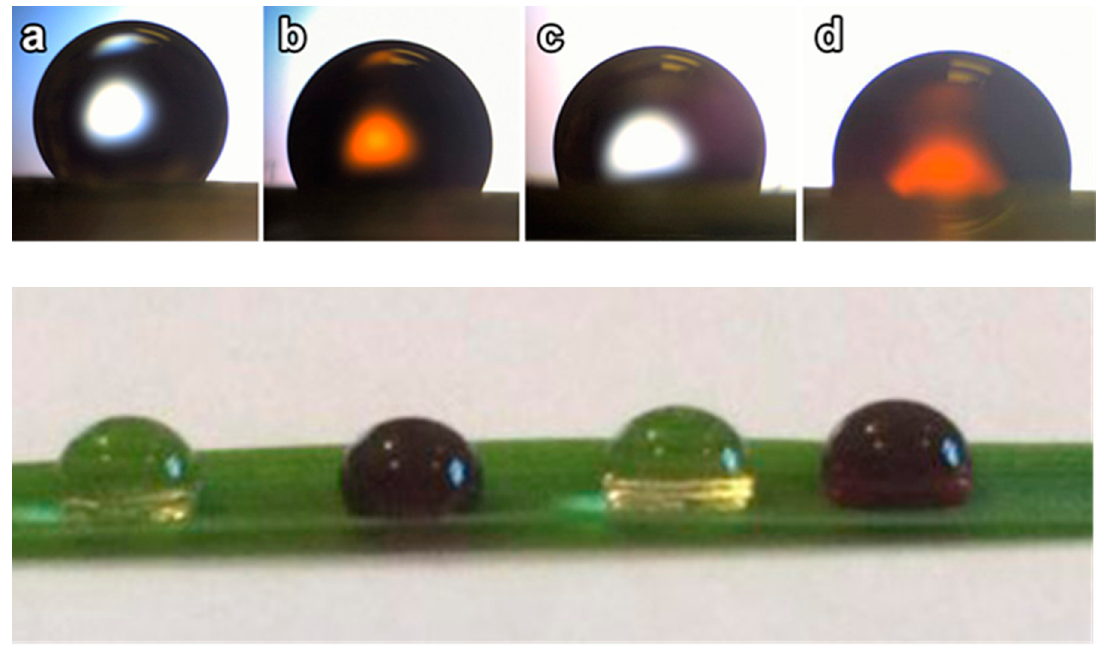
Figure 5. Images of the foliar spray droplets deposited on the surface of wheat leaf: ( a ) triple-distilled water; ( b ) HS (solution of potassium humate); ( c ) Fe-EDTA; ( d ) ferrihydrite nanoparticles (FH). All the solutions contained urea adjuvant (0.2% wt.). The image in the bottom row presents the total view of the droplets deposited on the surface of the wheat leaf.